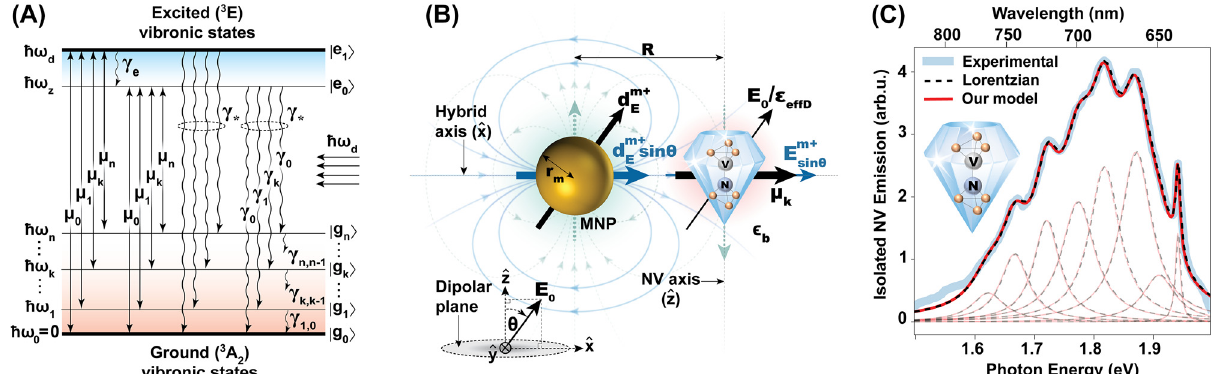
Figure 1: Optical model of the NV centre, example NV-MNP schematic and isolated NV emission spectra (theoretical and experimental). (A) } ( k ∈ { 0 , … , n } ) and two excited states | e ⟩ } with energies { ℏ𝜔 ⟩ and | e ⟩ . The Optical model of the NV center with n + 1 ground states { | g k 0 1 k ⟩ is a phenomenologically defined upper excited level resonant with the angular frequency of incoming radiation 𝜔 . Other state | e 1 d , dephasing rate 𝛾 ∗ , ground state phonon decay rate(s) 𝛾 , effective excited state parameters are, spontaneous photon emission rate(s) 𝛾 k k , k − 1 phonon decay rate 𝛾 , and zero phonon line (ZPL) energy ℏ𝜔 . (B) An example dimer setup where the NV-MNP hybrid axis lies along the NV e z and d m + denote the positive dipolar plane. Optical illumination is polarized along a plane perpendicular to the NV dipolar plane. E 0 E sin 𝜃 ∕ 𝜖 frequency amplitudes (coefficients of e − i 𝜔 d t ) of the external field and the MNP dipole formed by the external field, respectively. E 0 effD and E m + denote the screened projections of the external field and the MNP dipole response field onto the NV dipolar plane, at the NV sin 𝜃 location. (C) The experimentally measured emission spectrum of an isolated NV center in air at room temperature and the fitted Lorentzian sum reported by Albrecht et al. in [18] are denoted by the solid blue and dashed black lines. The output of our extended NV model in (A) implemented as an open quantum system is plotted in red. Individual emission lines are shown with reduced opacity. Both theoretical and experimental spectra including the fitted Lorentzians and the individual emission bands are normalized by the area of the respective total emission curve. The inset conceptually illustrates the NV center embedded in a